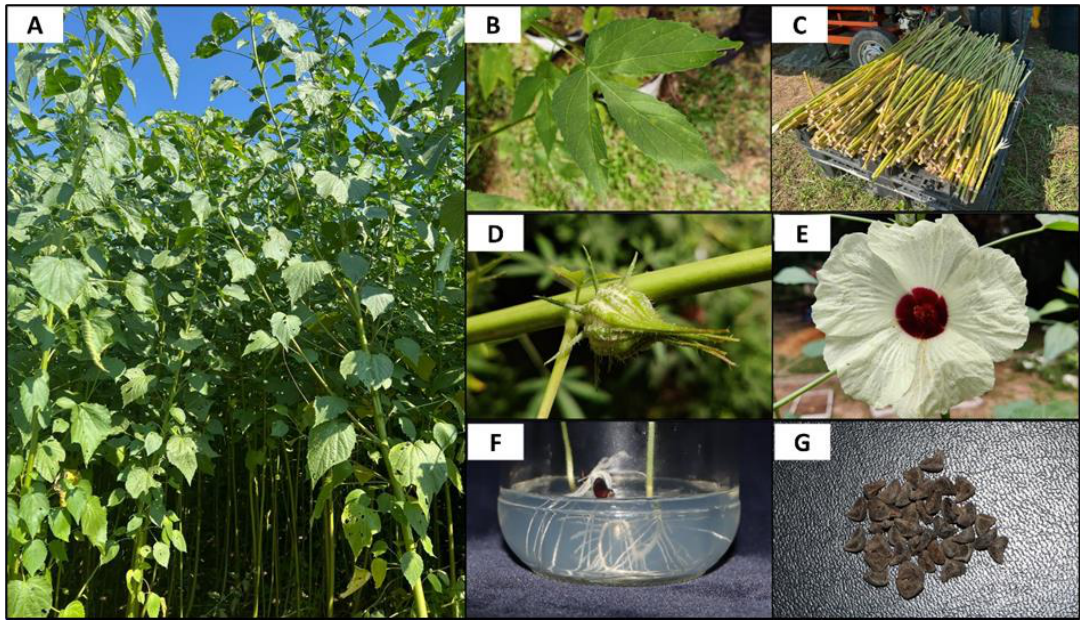
Figure 1. Hibiscus cannabinus . ( A ) Whole plant. ( B ) Leaf. ( C ) Stems. ( D ) Fruit. ( E ) Flower. ( F ) Roots. ( G ) Seeds.